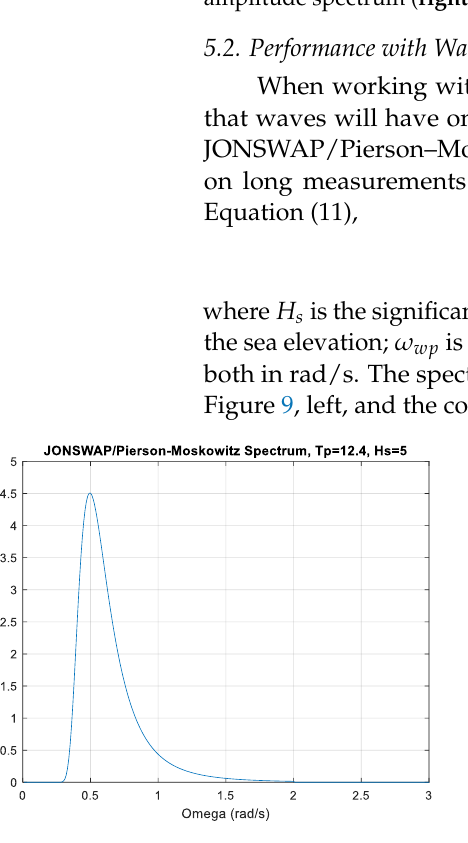
Figure 9. Wave spectral density ( left ) and wave elevation ( right ). 𝐻 𝑠 = 5, 𝜔 𝑤𝑝 = 0.5067.